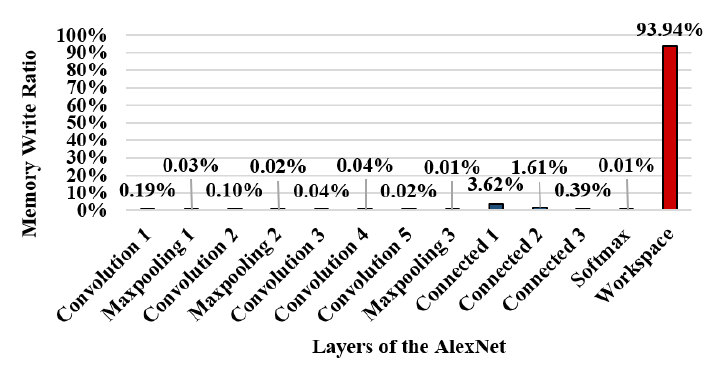
Figure 6. Memory write ratio per layer in AlexNet.